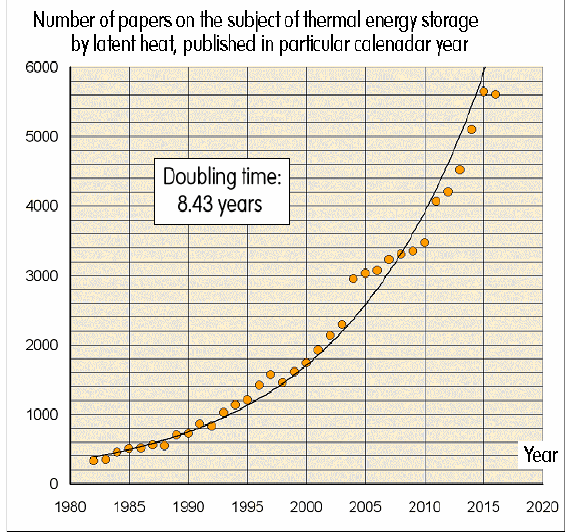
Fig. 4. Interest in storage of thermal energy in latent heat of a phase change has been steadily increasing as documented by the annual number of published papers – data from